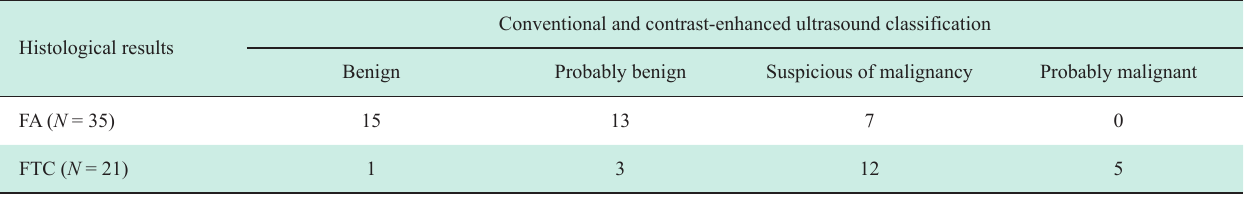
Table 5 Diagnostic performance of conventional and contrast-enhanced ultrasound for discrimination between FA and